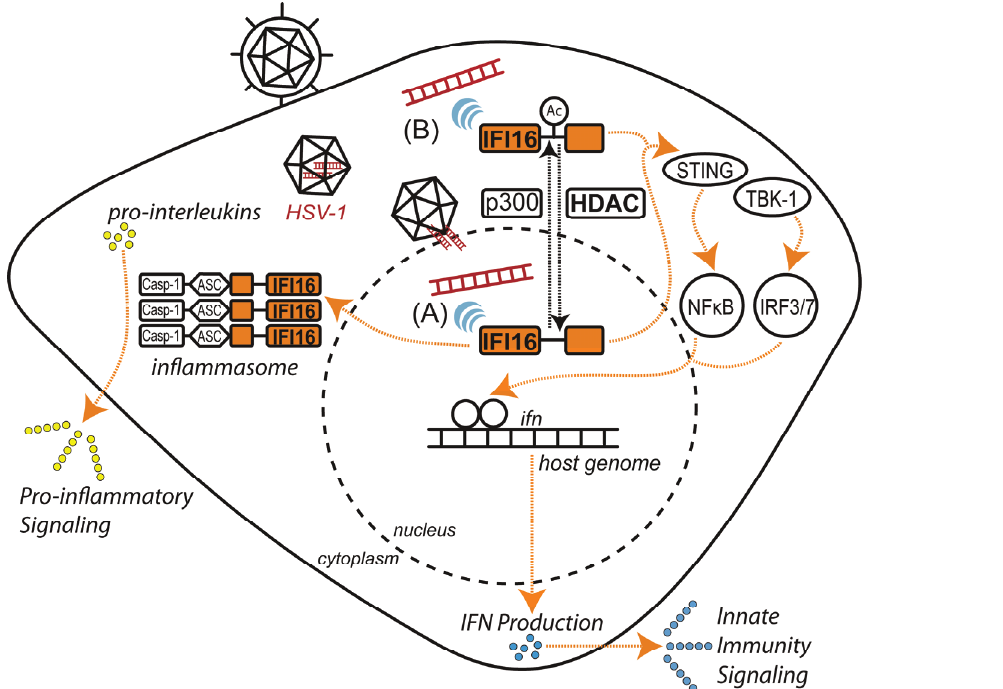
Figure 2. Host response to viral DNA is mediated by IFI16. Acetylation-dependent localization of IFI16 allows dual-compartment sensing of viral DNA, promoting pro-inflammatory response and innate immune signaling during herpesvirus infection. ( A ) IFI16 senses HSV-1 DNA within the nucleus. ( B ) IFI16 senses cytoplasmic DNA resulting from transient transfection or viral capsid